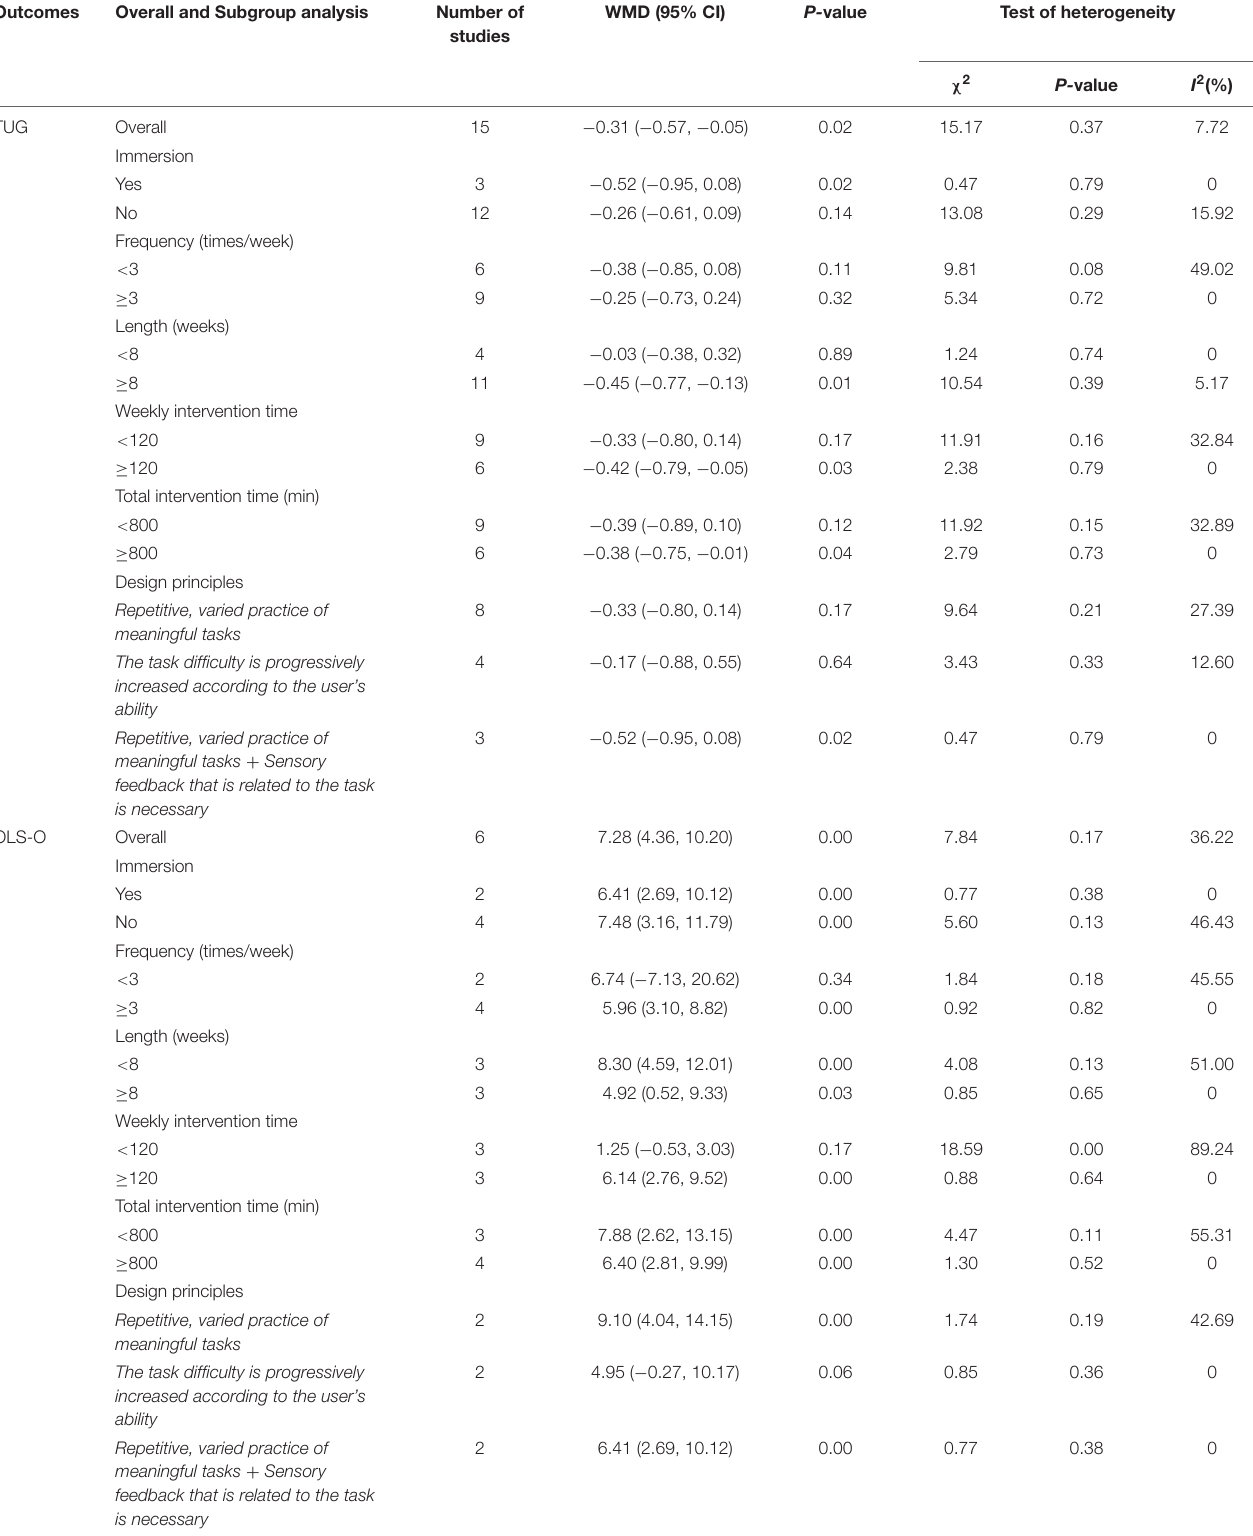
TABLE 3 | Overall and subgroup analysis results regarding the effects of VRT on balance and functional mobility. Outcomes Overall and Subgroup analysis Number of WMD (95% CI) P- value Test of studies